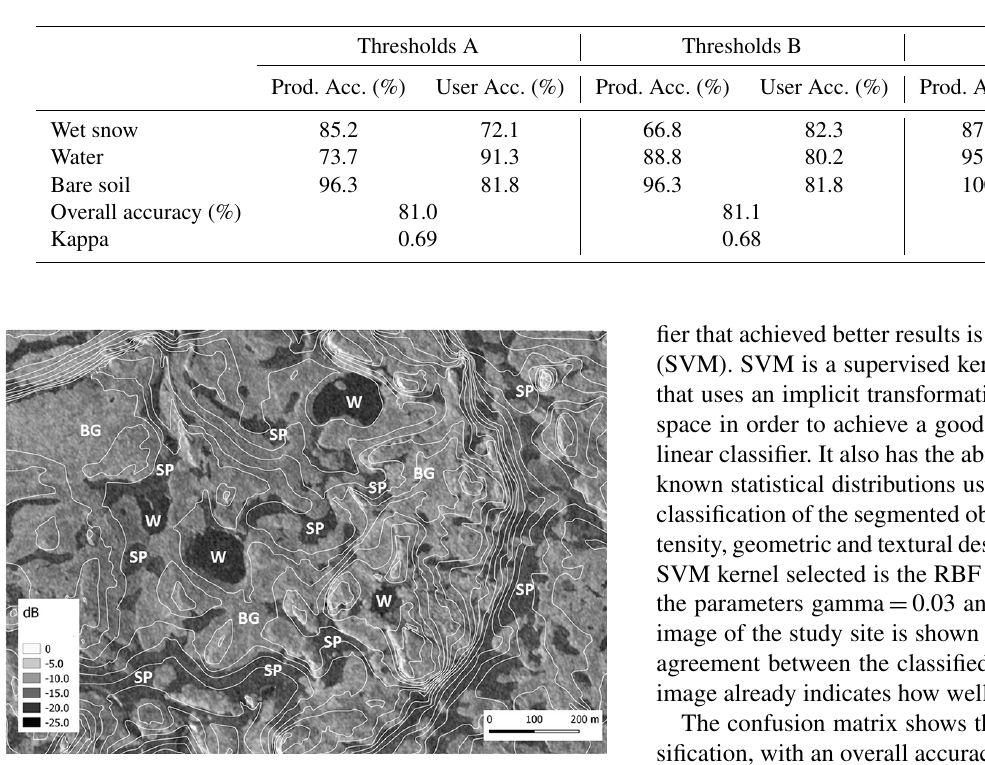
Figure 11. Scatter plots of snow density (a) and snow grain size (b) with backscattering for the studied snow patches. Table 4. Performances for the three tested classifications. Classification Threshold A: backscattering threshold water – wet snow at − 20.5dB, Classification Threshold B: backscattering threshold water – wet snow at − 19.5dB, and Object-oriented approach. Producer accuracy mea- sures the errors of omission (pixels correctly classified as a percentage of the total number of pixels that belong to that class). User accuracy measures the errors of commission (the number of correctly classified pixels compared to the total number of pixels assigned to that class).